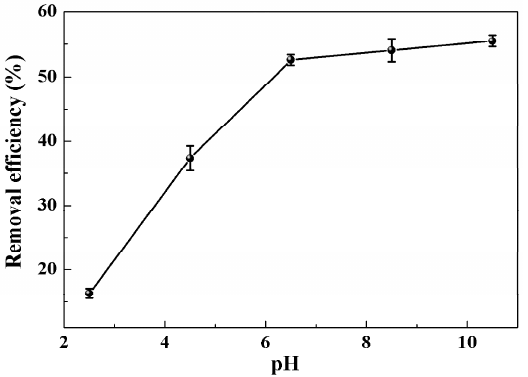
Figure 9. Effect of pH on the removal rate of MB (dosage of the adsorbents: 1.0 g/L; initial concentration: 200 mg/L).